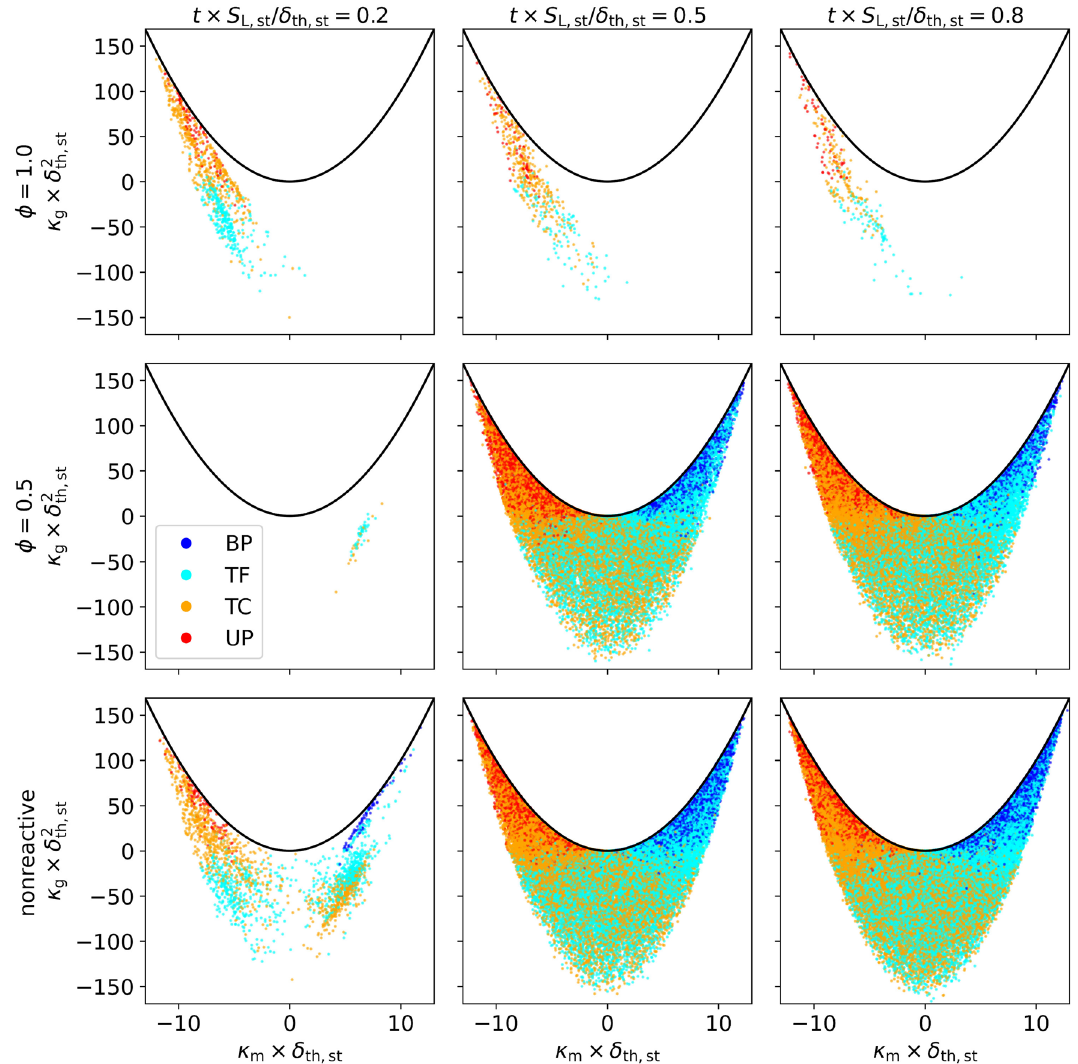
κ g plane for the normalized times −